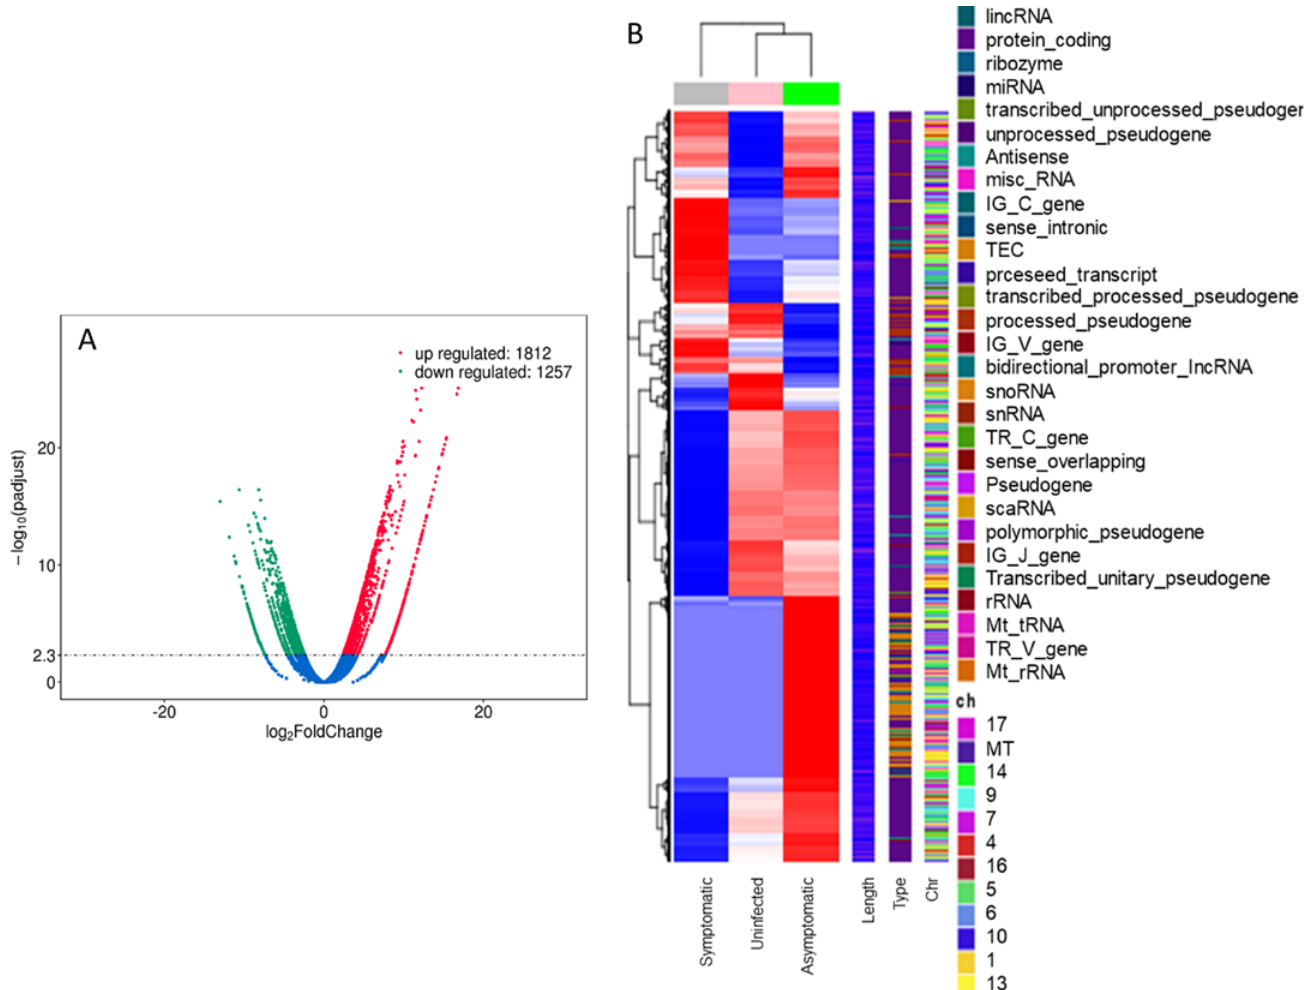
Figure 2. ( A ) Volcano plot (RNA-seq); symptomatic CDI mice had 1812 upregulated and 1257 down- regulated genes compared with uninfected mice. ( B ) Overall cluster analysis of differential expression between C. difficile -infected symptomatic, asymptomatic mice, and uninfected mice. Table 1. Log 2 fold-change of selected genes between infected symptomatic mice when compared 3.4. Difference in Microbiome Composition of Infected Symptomatic and Asymptomatic with uninfected or infected asymptomatic mice.